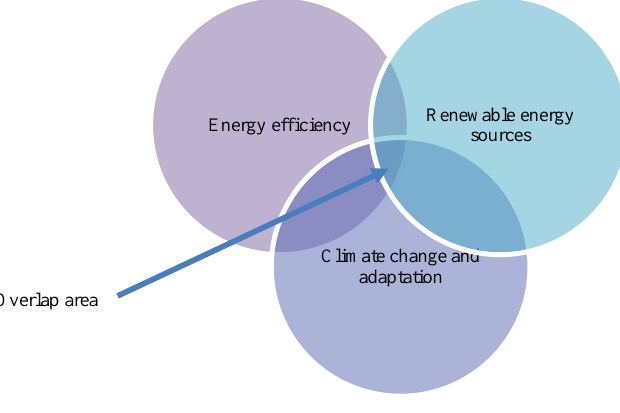
Fig. 1. Energy systems' development triple